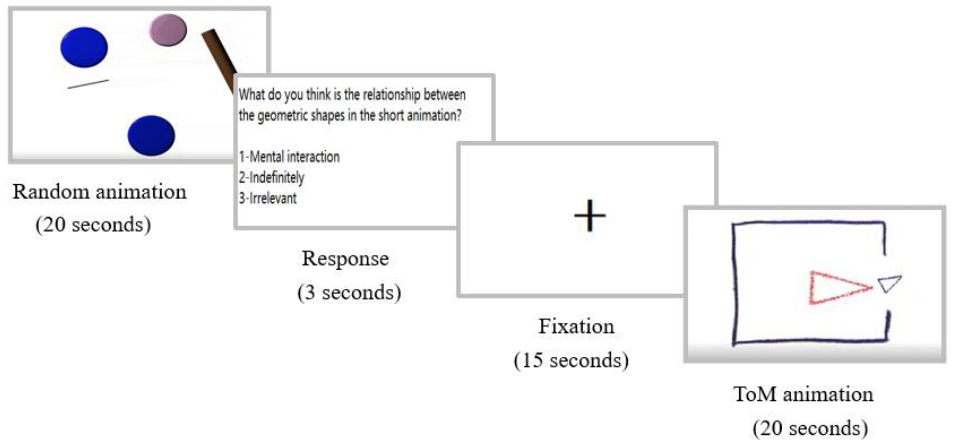
Figure 2. Flow chart of the animated triangle